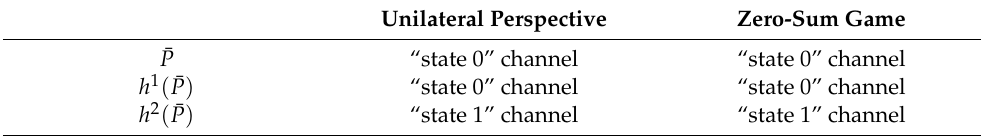
Table 8. The optimal polices of sensor under different scenarios.